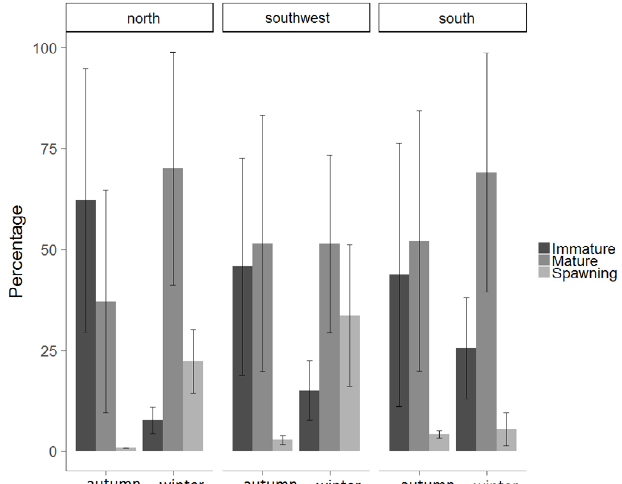
Fig. 5. The percentage immature, mature and spawning fi shes, data combined from both sexes, in the samples by season (autumn and winter) and for each of the three areas (north, southwest and south).